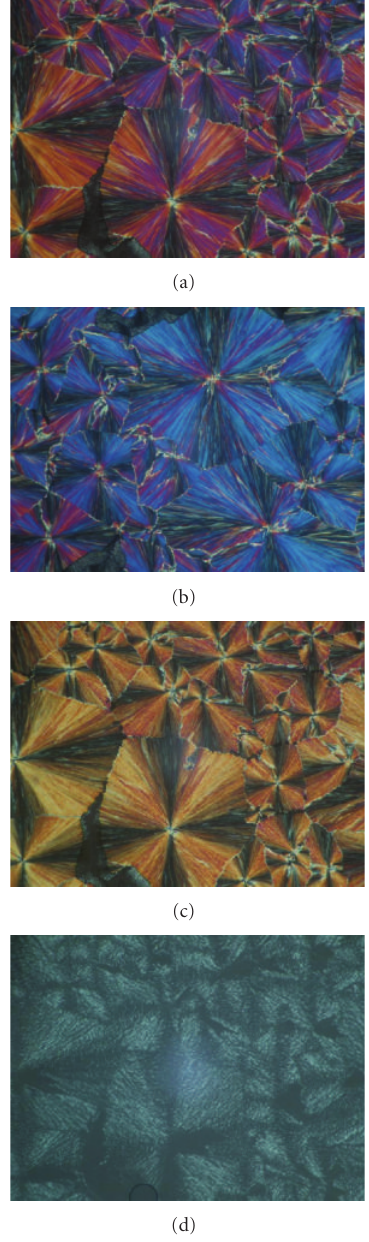
Figure 7: Polarized optical micrographs of cholesteryl nonanoate taken during heating from the solid phase at (a) 25 ◦ C, (b) 55 ◦ C, (c) 72 ◦ C, and (d) 85 ◦